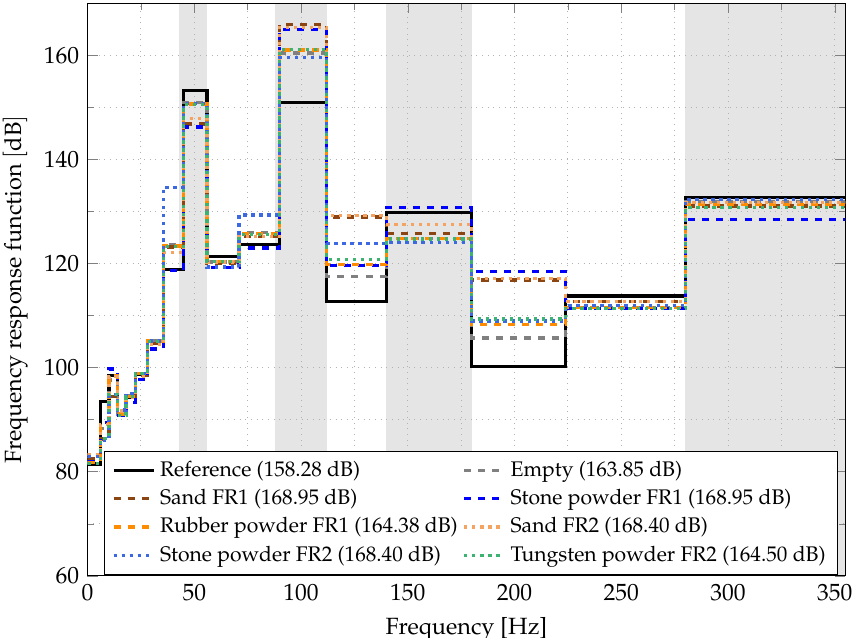
Figure A4. One-third octave band representation of FRF of WTS test specimen. SU HCDP mounted to the outer wall of the stator ring (opposite to the excitation point). SL of surface velocity is given in dB.